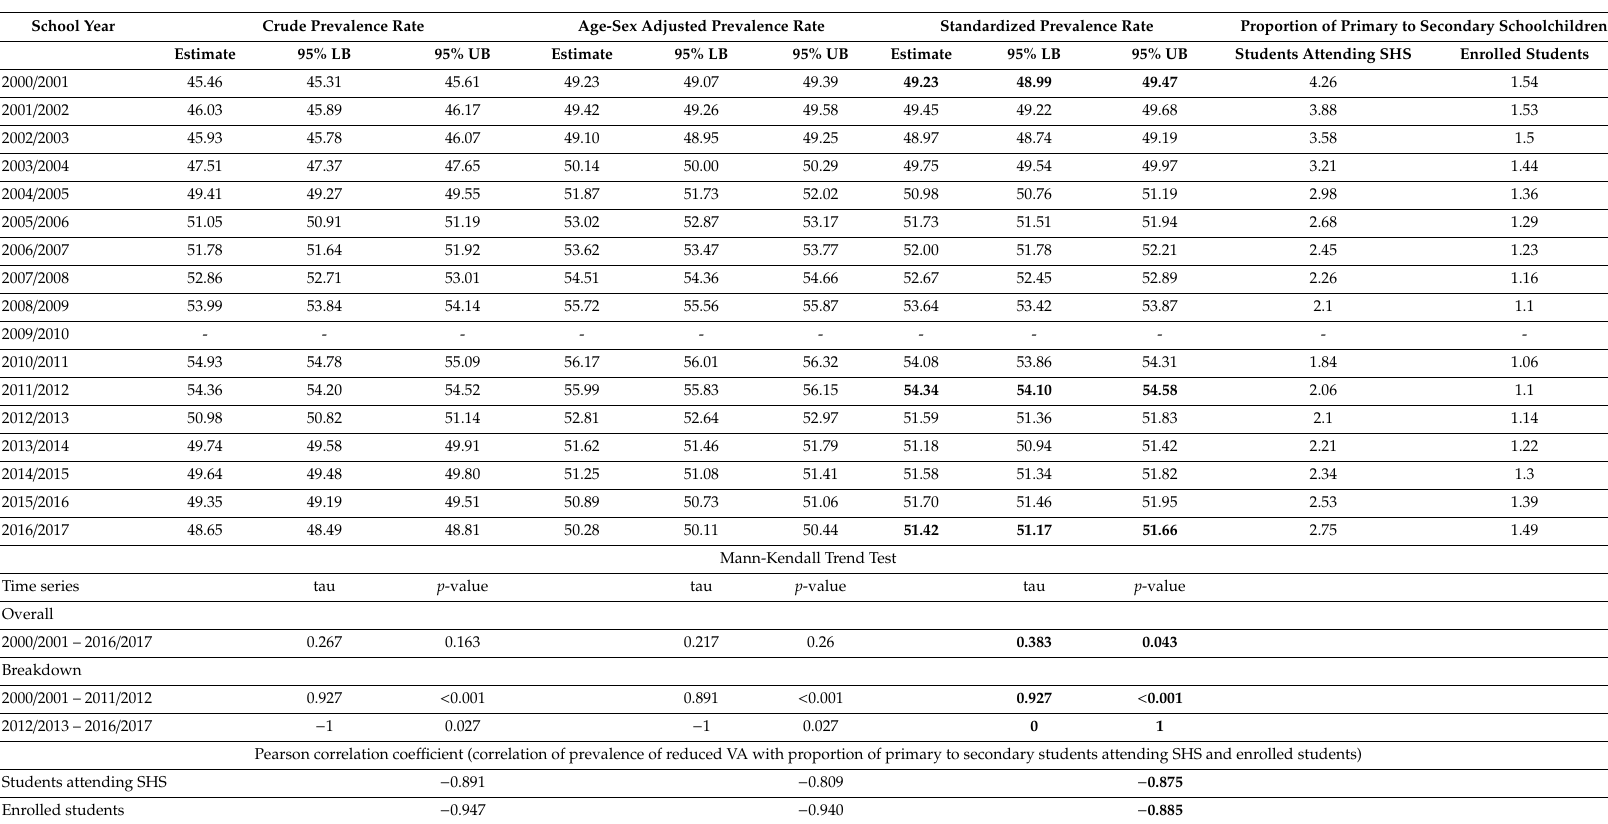
Table 1. Prevalence of reduced visual acuity in the schoolchildren of Hong Kong and its correlation with the proportion of primary to secondary schoolchildren from 2000 / 2001 to 2016 / 2017. School